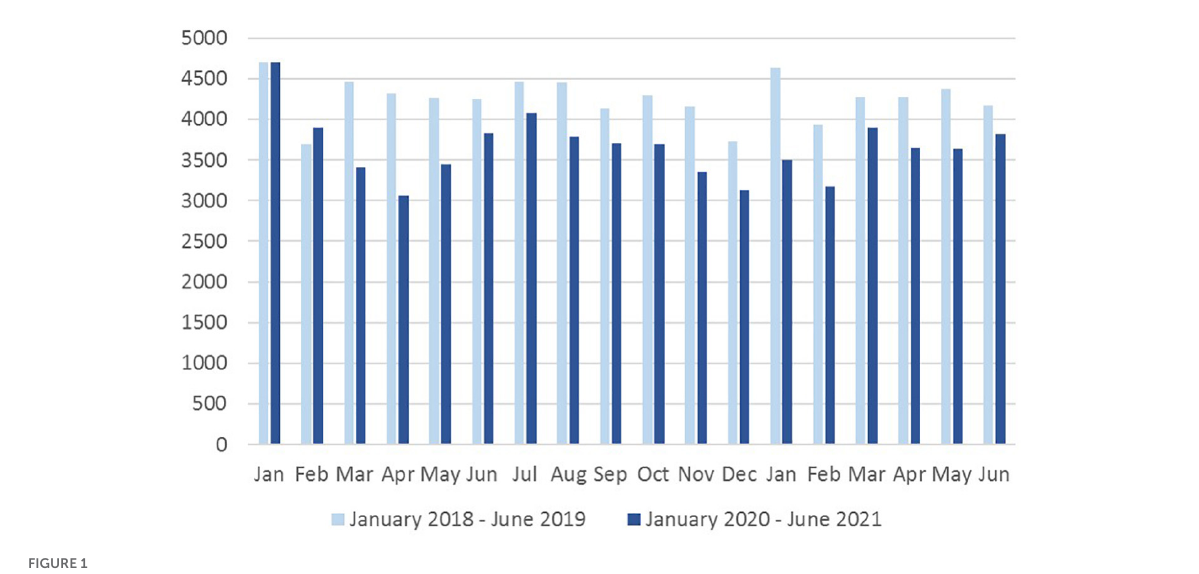
FIGURE1 Monthly admission rates. Shown are the monthly admission rates in the adult psychiatric departments of nine psychiatric hospitals of the Rhineland region in Germany in the time periods 1 January 2018 until 30 June 2019 (light blue bars) and 1 January 2020 until 30 June 2021 (dark blue